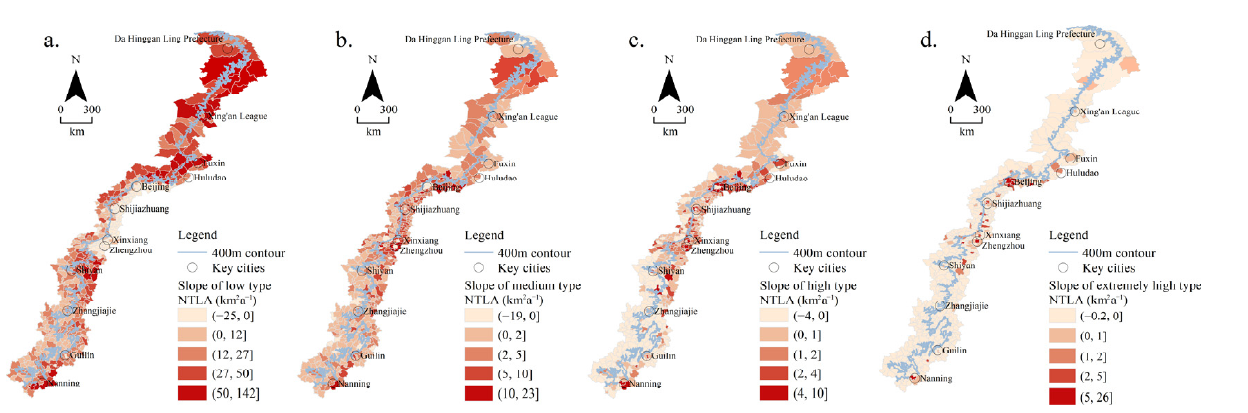
Figure 9. Slope changes in different types of nighttime light: ( a ) low types; ( b ) medium types; ( c ) high types; ( d ) extremely high types.